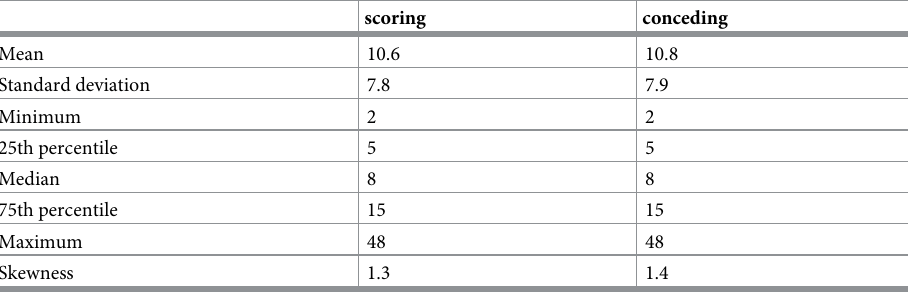
Table 4. Descriptive statistics for the scoring and conceding